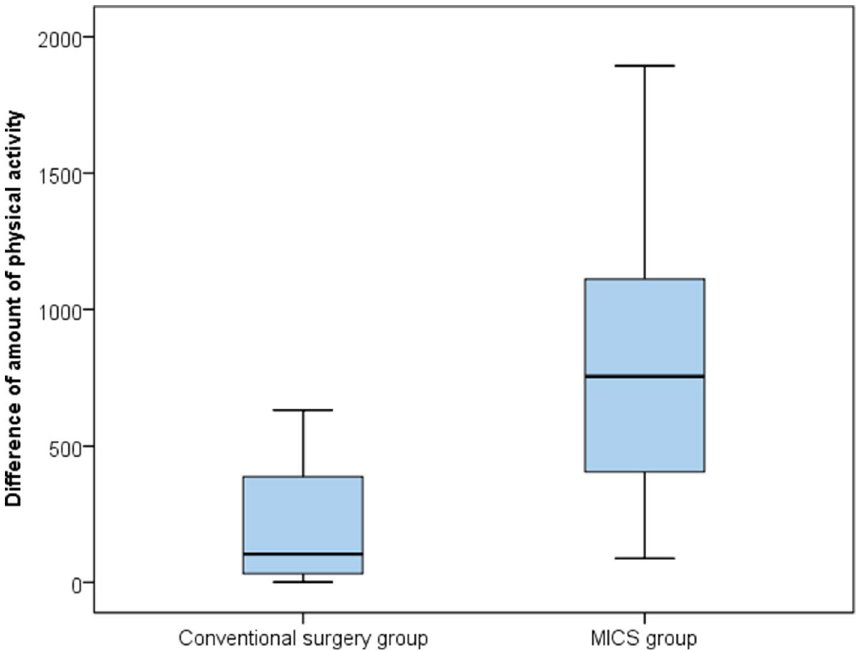
Fig. 2 The deference of The amount of physical activity before and after surgery measured by triaxial accelerometer (steps/ day)